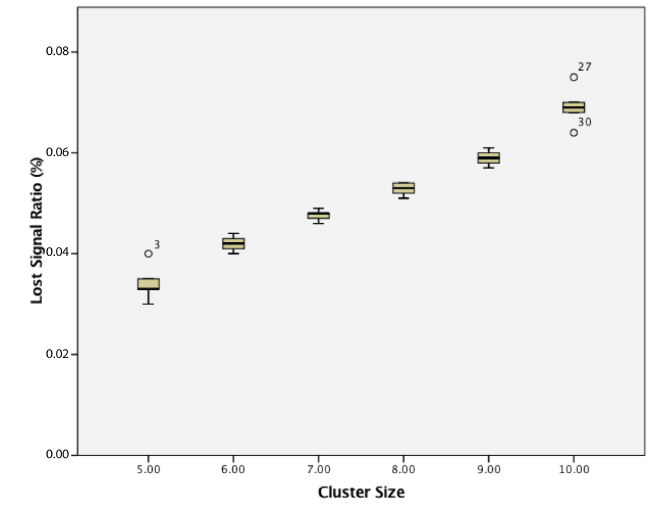
Figure 18. The effect of cluster size on the lost signal ratio of a cluster of active wireless sensor networks.